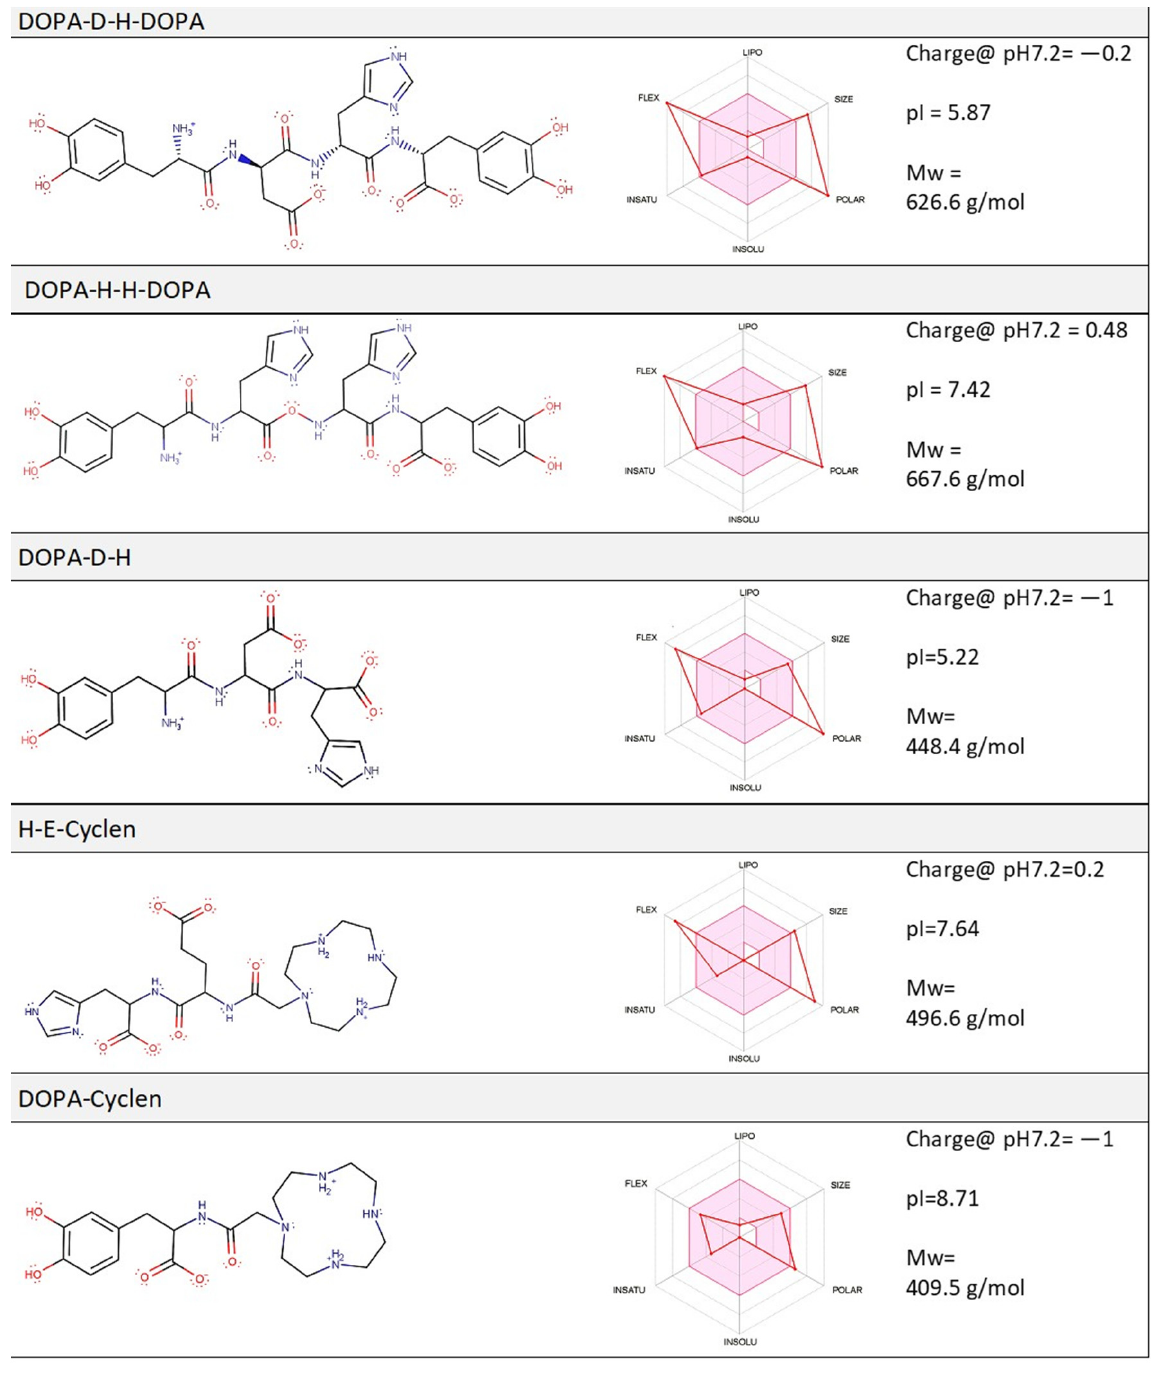
Figure 1. Schematic presentation of chemical structures and physico-chemical properties of selected compounds: DOPA-D-H-DOPA, DOPA-H-H-DOPA, DOPA-D-H, H-E-cyclen, and DOPA-cyclen. Schematic presentations of molecules are shown combined with ADME radar diagrams, depicting their six physico-chemical properties and drug likeness, i.e., how much the molecular properties fall into the pink area.